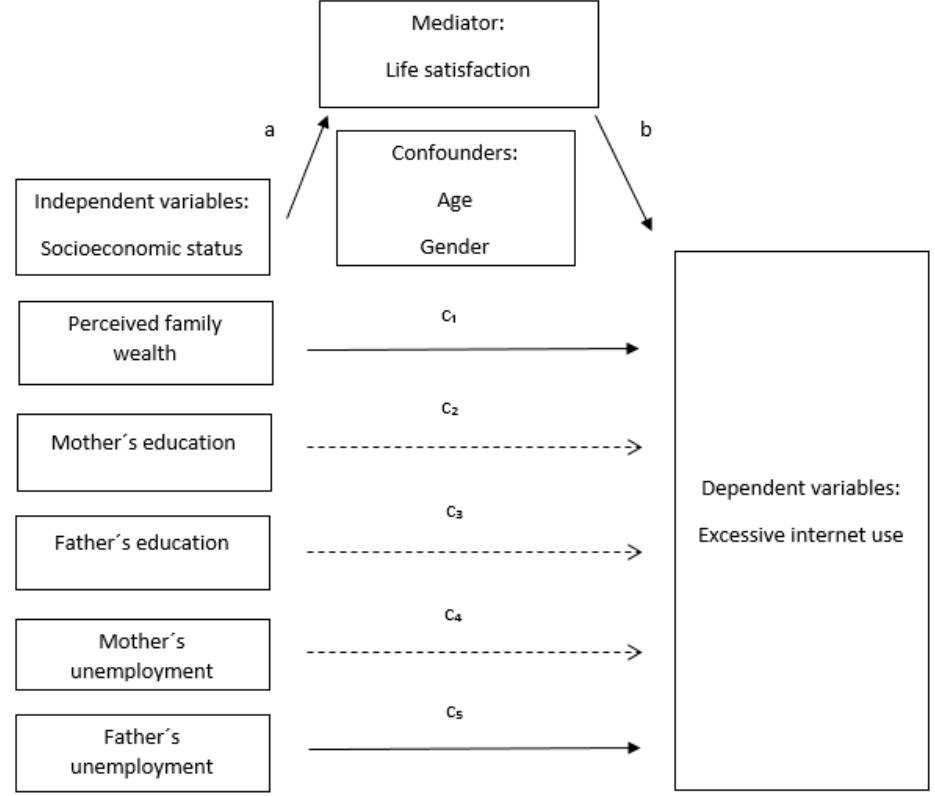
Figure 1. Conceptual model for the mediating effect of life satisfaction on the association between socioeconomic status and excessive Internet use. a = Association between indicators of socioeconomic status and the potential mediator, life satisfaction. b = Association between the mediator and excessive Internet use. C ₁ - ₅ = Direct associations between indicators of socioeconomic status and excessive Internet use, adjusted for the mediator. Confirmed mediation. Not confirmed mediation.